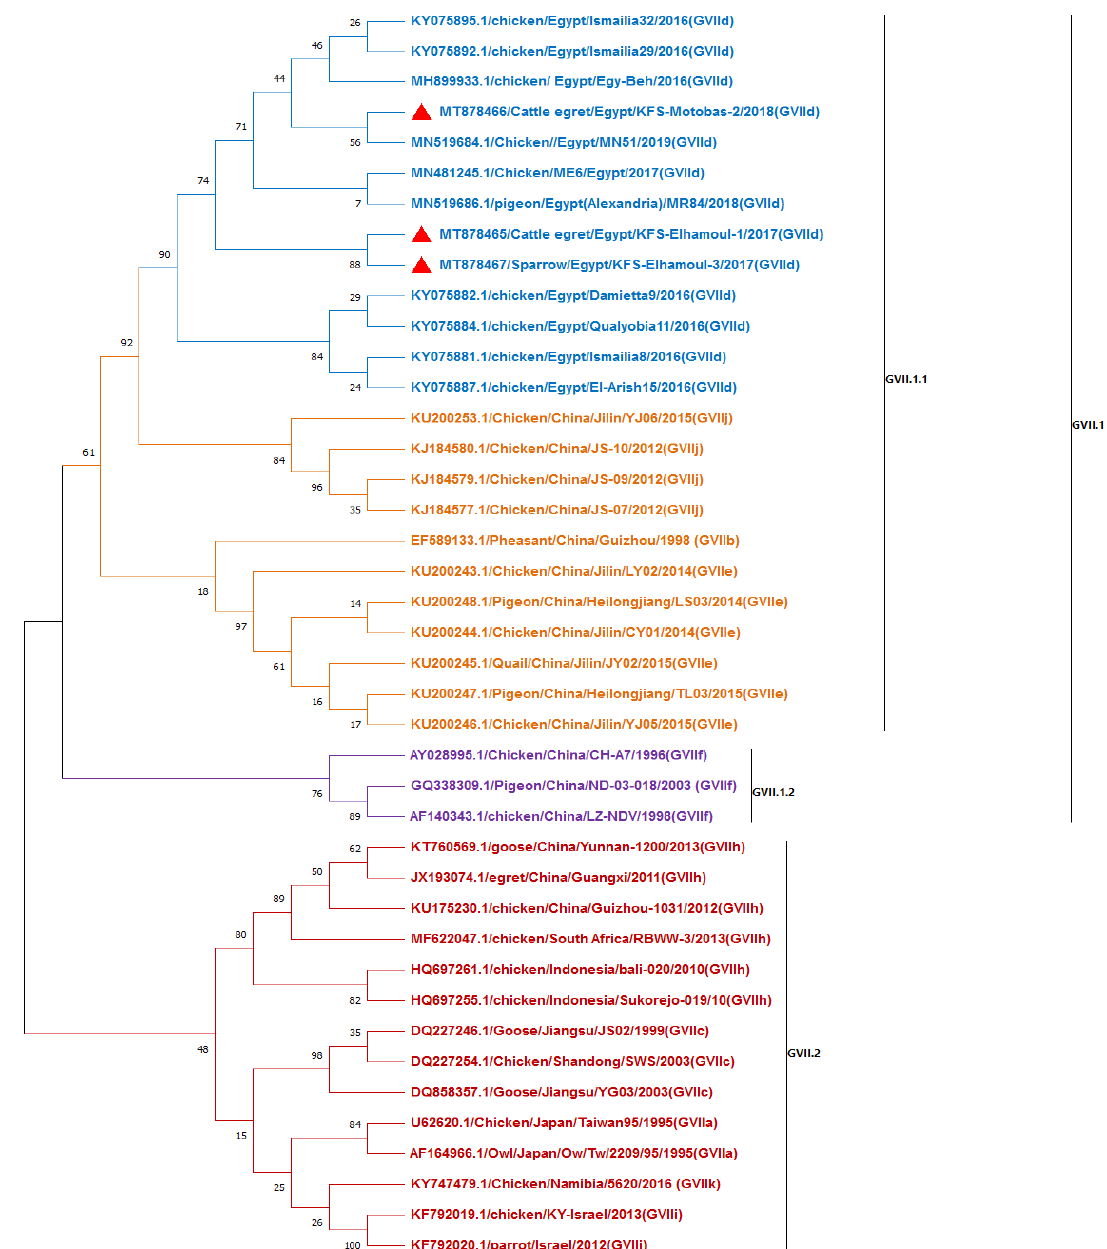
Figure 2. Phylogenetic maximum-likelihood tree of NDV F gene fragment sequences with 1000 bootstrap repeats, including GVII sub-genotypes. Our strains KFS-Motobas-2, KFS-Elhamoul-1, and KFS-Elhamoul-3 (red triangles) were aligned with other GVII.1.1 strains obtained from GenBank.